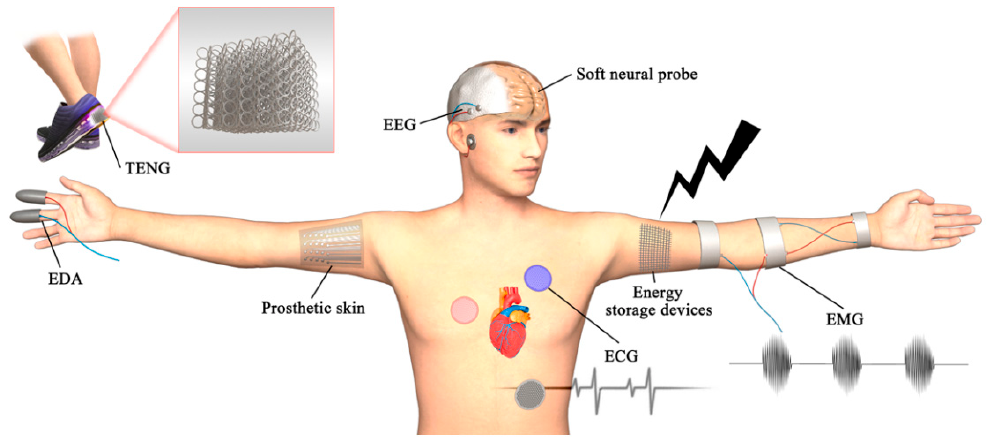
Figure 16. Applications of 3D printing in flexible and wearable devices. Figure reproduced from [9].